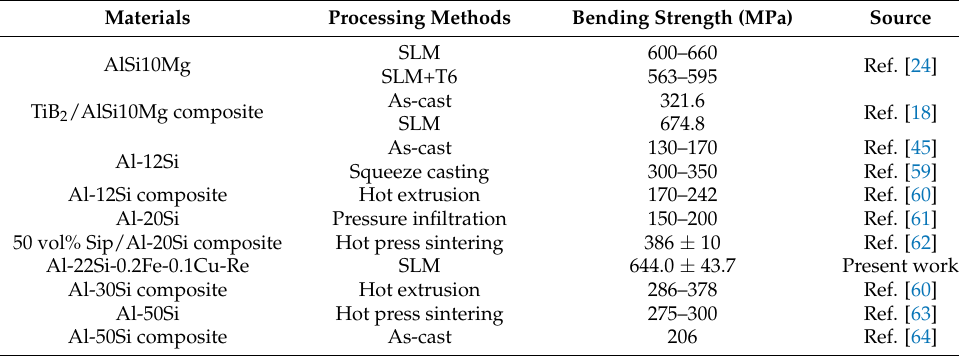
Table 5. Bending data for the Al-Si alloys manufactured by different methods.